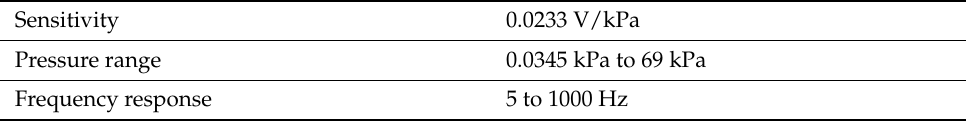
Table 2. Instantel high-pressure microphone characteristics used to measure air overpressure.